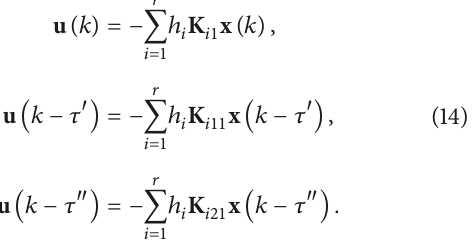
Figure5:Productionevolutionprocessesunderthecommonrobust strategy ( ×10 4